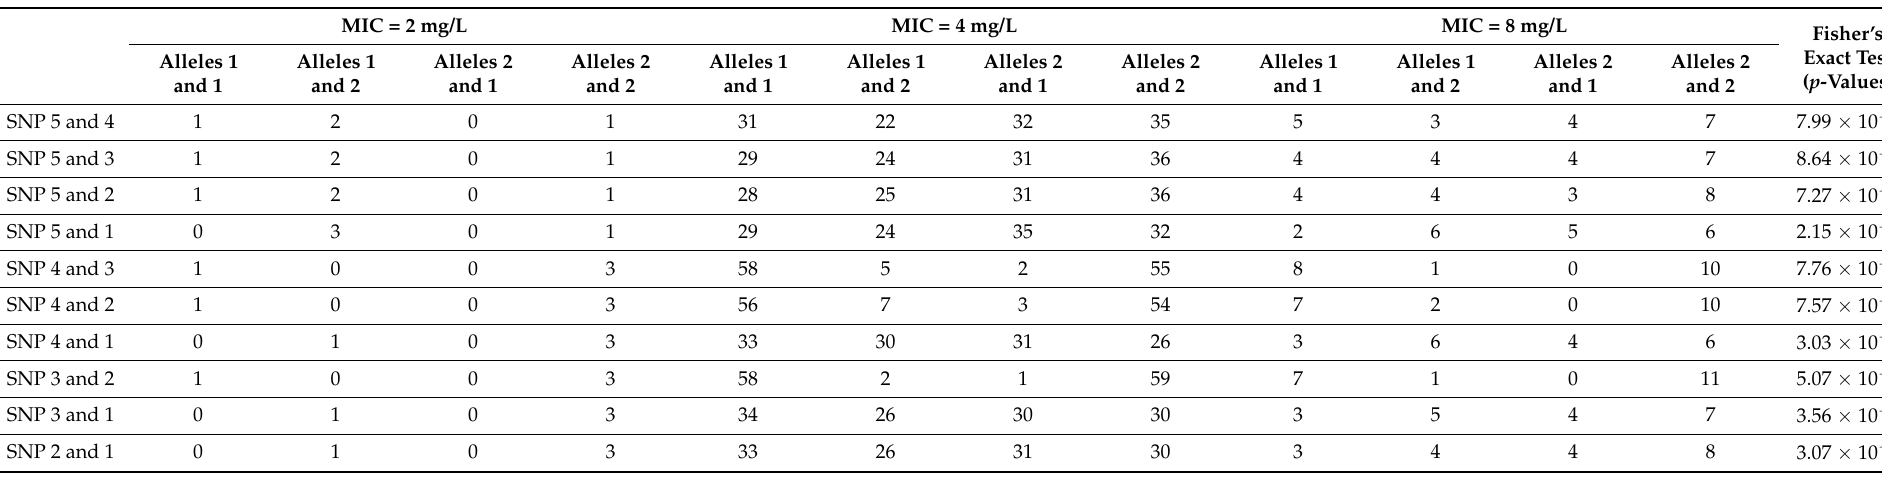
Table 7. Distribution of pairwise genotype combinations at five SNP sites among the 143 progeny strains. The variant alleles are separated based on AMB MIC groups (MIC = 2 mg/L, 4 mg/L or 8 mg/L). Fisher’s exact tests (4 × 3 contingency table) were conducted between MIC groups and the inherited parental allele, with p -values listed. Differences were considered statistically significant at p <